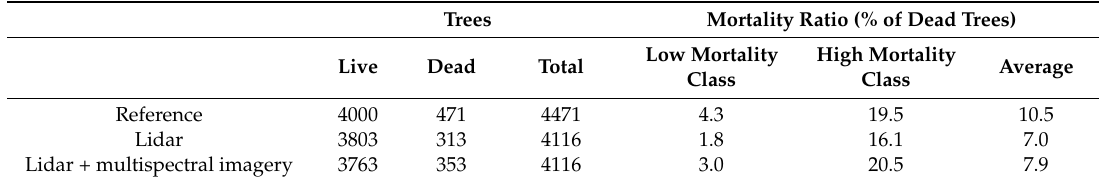
Table 4. Random forest predictions of tree status and mortality ratios after a lidar-based classification or after a combined lidar-multispectral imagery-based classification.